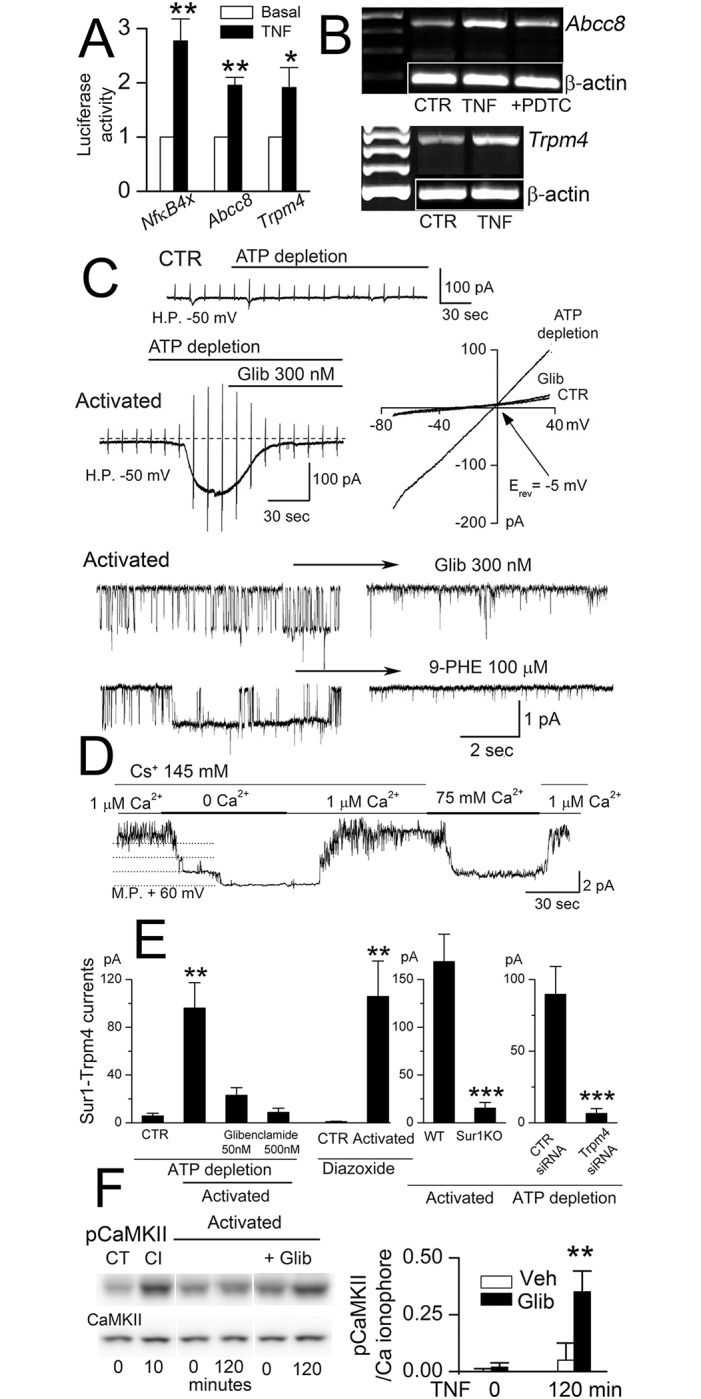
SUR1-TRPM4 channel upregulation in vitro.A: Activity of the Abcc8 promoter, the Trpm4 promoter and a positive control (four consecutive NF-κB consensus sequences), under basal conditions and after stimulation by TNF (20 ng/mL); 3 replicates; *, P<0.05; **, P<0.01. B: Murine BEC were exposed to TNF (20 ng/mL) and lysate was analyzed by RT-PCR 16 hours later; transcripts for Abcc8 and Trpm4 were upregulated compared to control (CTR); the induction of Abcc8 mRNA by TNF was reduced by the NF-κB inhibitor, PDTC (pyrrolidinedithiocarbamate); β-actin mRNA was used as a loading control; representative of 3 replicates. C: Macroscopic and single channel (inside-out patch) currents induced by ATP depletion in activated but not in non-activated (CTR) murine BEC; currents were blocked by glibenclamide (Glib) and 9-phenanthrol (9-PHE). D: Single channel current in an inside-out patch with 4 single channel levels during changes in bath solution from 145 mM Cs+/1 μM Ca2+, 145 mM Cs+/0 μM Ca2+,145 mM Cs+/1 μM Ca2+, 0 mM Cs+/75 mM Ca2+, 145 mM Cs+/1 μM Ca2+. E: Quantification of macroscopic currents at –50 mV induced by ATP depletion or diazoxide in activated or non-activated (CTR) murine BEC; currents were blocked by glibenclamide and by gene deletion of Abcc8 (SUR1KO) and gene suppression of Trmp4 (siRNA); cells/condition for each bar: 35, 12, 14, 19, 11, 11; 24, 19; 9, 13; **, P<0.01; ***, P<0.001. F: Immunoblots for pCaMKII and CaMKII, with densitometric quantification of pCaMKII in murine BEC without activation, under control conditions (CT) and after exposure to the Ca2+ ionophore (CI), A23187 (5 μM × 10 minutes), and in activated BEC exposed to TNF in the absence and presence of glibenclamide (Glib); both bands shown had molecular masses of 50 kD, corresponding to pCaMKIIα and CaMKIIα; pCaMKII normalized to levels induced by A23187; n = 5.